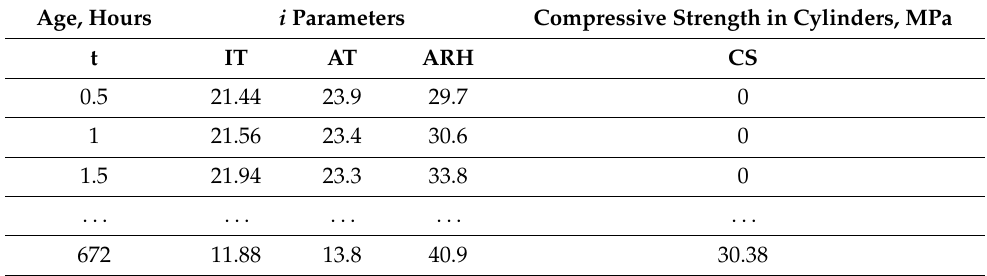
Table 1. Laboratory testing log template to retrieve the complex maturity–strength relationship. Age,